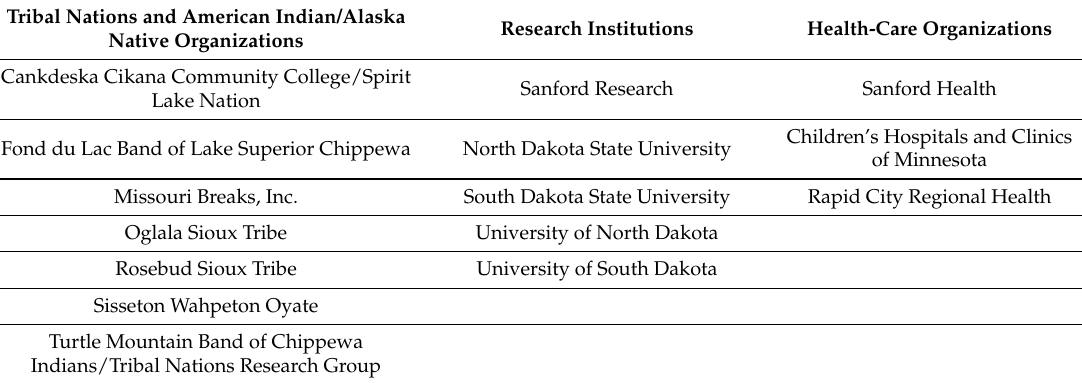
Table 2. Collaborative Research Center for American Indian Health Partners. Tribal Nations and American Indian/Alaska Native